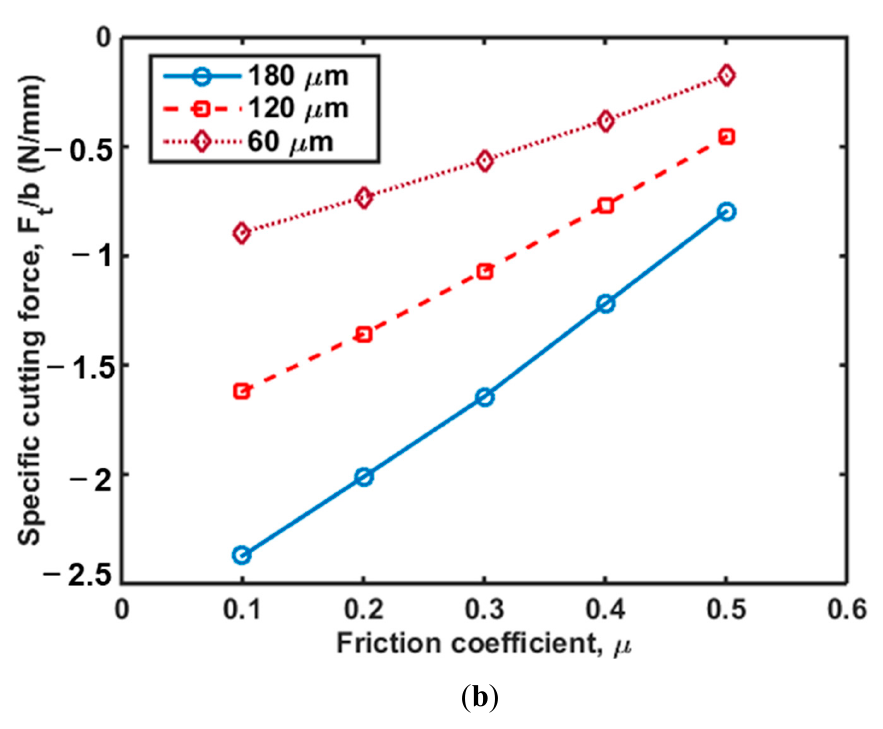
Figure 10. Cutting force in ( a ) cutting direction and ( b ) transverse direction as a function of friction coefficient in HDPE with a rake angle of 30°.